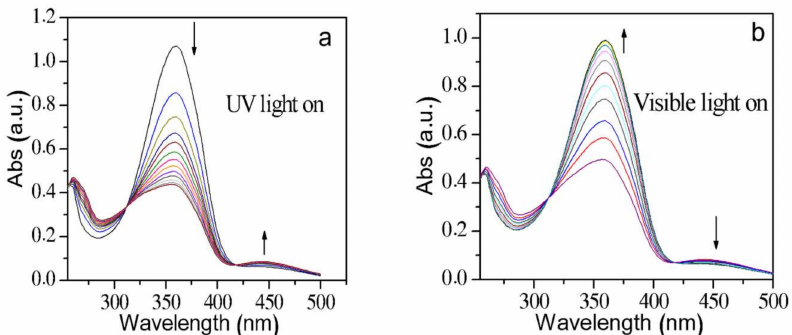
Figure 7. Compound 2c in CH 2 Cl 2 at 20 ◦ C (0.002 wt %), ( a ) change in absorption of UV-Vis spectra over time under UV light (365 nm, 3.8 mW/cm 2 ) and ( b ) change in absorption of UV-Vis spectra over time under visible light (12.1 mW/cm 2